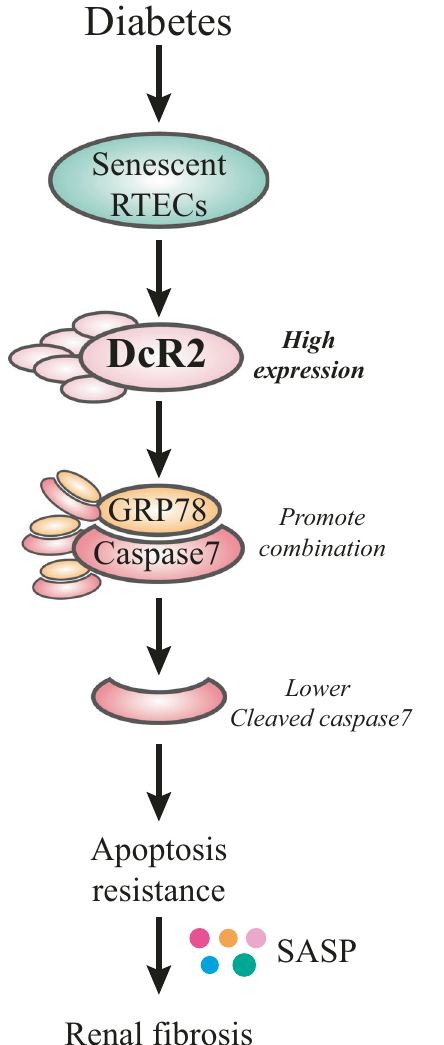
Fig. 8 Schematic showing how DcR2 – GRP78 may mediate the apoptosis-resistant phenotype of senescent tubular cells and renal fi brosis in DN. DcR2 is highly expressed in senescent renal tubular epithelial cells (RTECs) and mediates the apoptosis-resistant phenotype of senescent RTECs and renal fi brosis by interacting with GRP78, thereby contributing to progression of DN. DcR2 promotes the apoptosis-resistant activity of GRP78, leading to caspase 7 binding and Akt phosphorylation, which in turn result in persistent accumulation of senescent cells and SASP secretion, ultimately accelerating renal fi